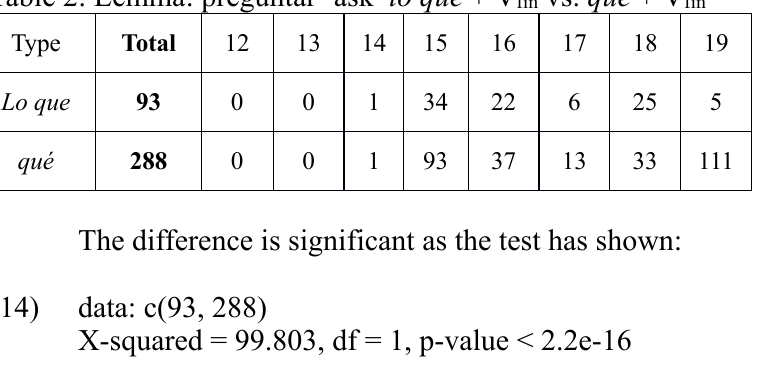
Table 2: Lemma: preguntar ‘ask’ lo que + V Type